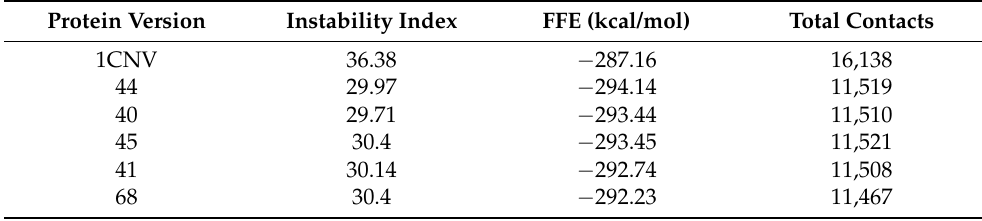
Table 1. Comparison between Native Concanavalin B (1CNV) and the 5 modified versions closer to native Concanavalin B (stability, free folding energy, and total contacts). Instability index is better for in vitro conditions at lower numbers (below 40 is considered stable), FFE = Free Folding